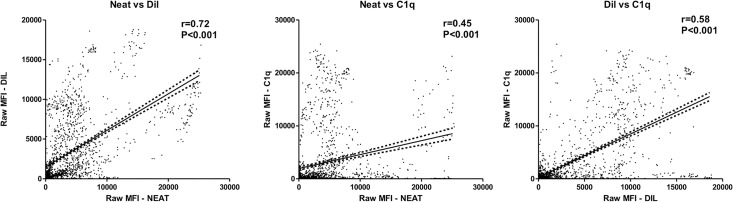
Correlation of raw MFI values after neat, diluted serum and C1q test.The raw MFI value after neat serum (neat), 1/160 diluted serum (DIL) and C1q test (C1q) were compared. The linear regression line and 95% confidence intervals in each plot are depicted (The correlation of MFI values was assessed by Spearman test (***, p<0.001).